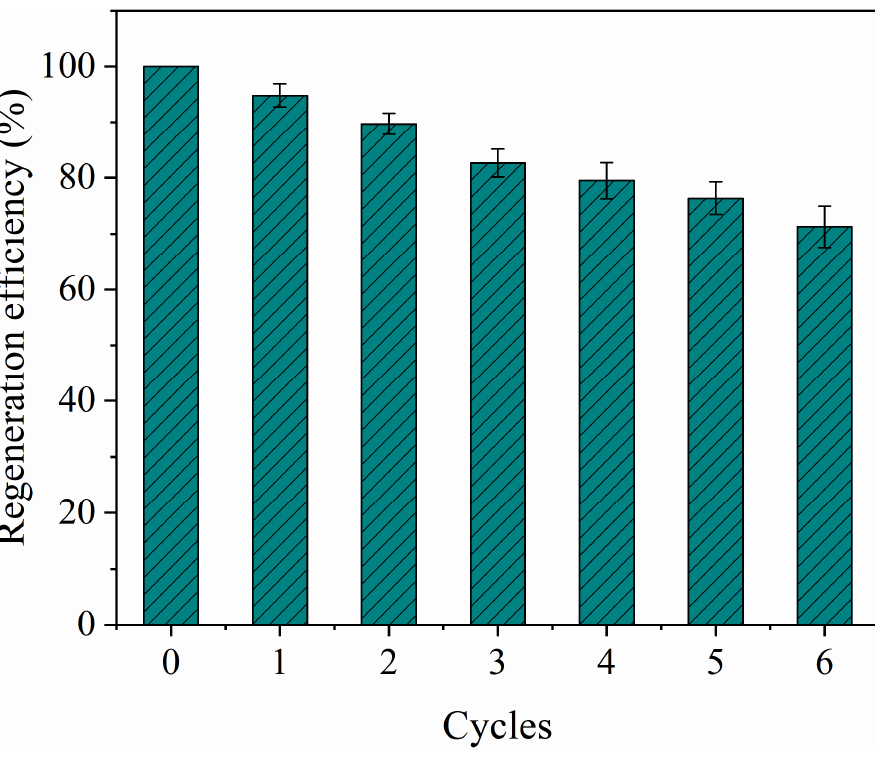
Figure 6. Reuse of PYCS in removal of Fe (III) from acidic wastewater.